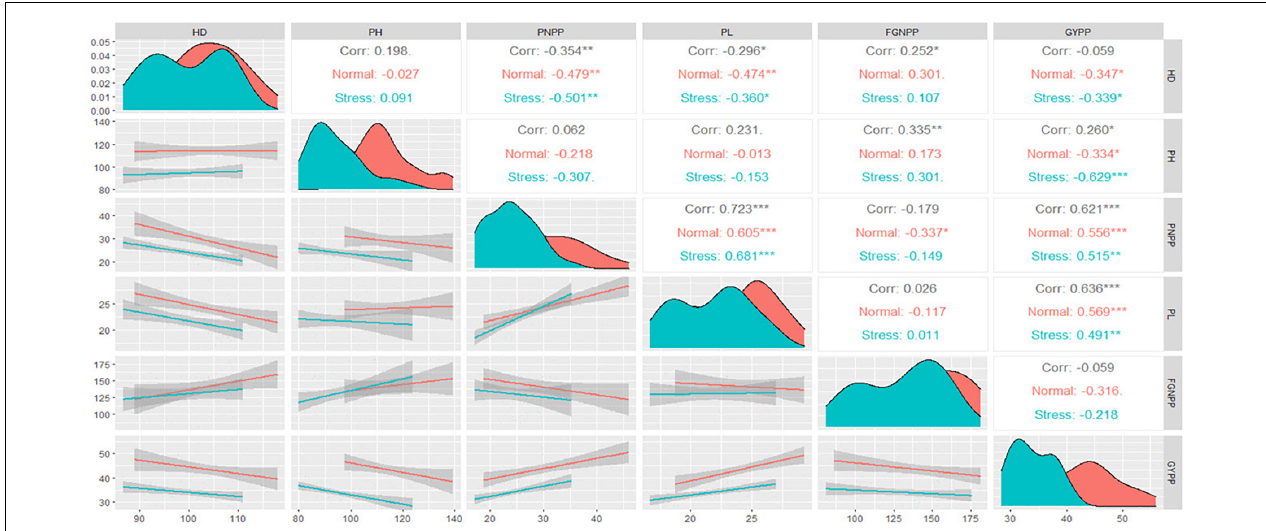
FIGURE 2 | Spearman correlation matrix for the traits studied under normal and water stress conditions. HD, number of days to 50% heading; PH, plant height; PNPP, panicle number per plant; PL, panicle length; FGNPP, number of filled grains per panicle; GYPP, grain yield per plant. *, ** and *** indicate significance at 0.05, 0.01 and 0.001 probability levels,